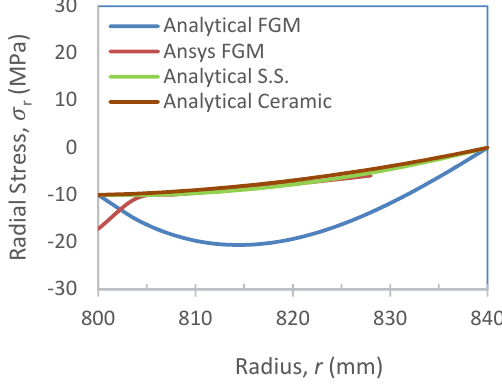
Figure 7. The variation of radial stress with cylinder radius.